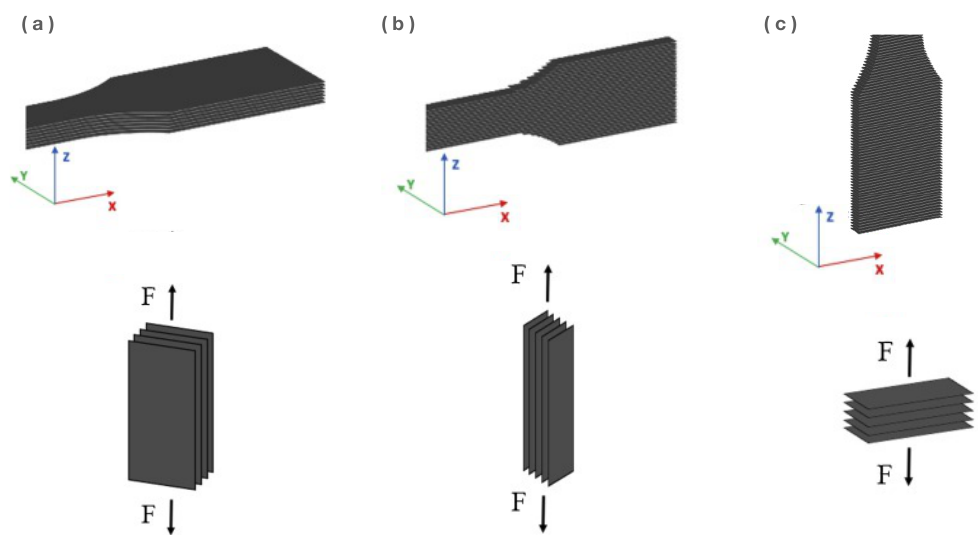
Figure 3. The printing direction of the sintered layers, where the layers of a 3D-printed tensile bar are oriented in ( a ) the x -direction, ( b ) the y -direction, and ( c ) the z -direction. F corresponds to the loading direction. Reproduced with permission [72], Copyright 2021,